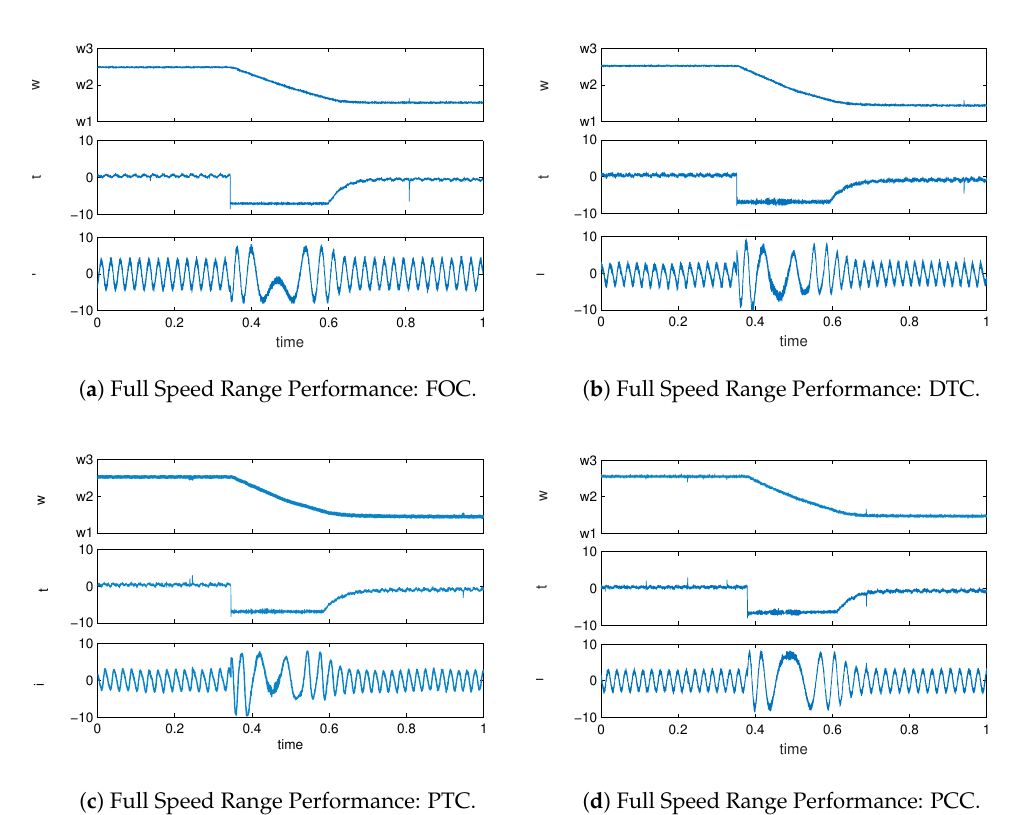
Figure 5. Experimental results: overall performance of three strategies during speed